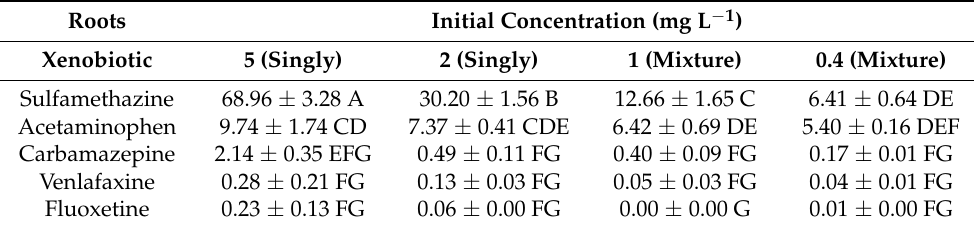
Table 4. Xenobiotic concentration in roots in Tripolium pannonicum. The values 5 and 2 in the table header represent the singly xenobiotic concentration and the values 1 and 0.4 represent each xenobiotic concentration in a mixture of the five xenobiotics in milligram per litre. Values show the mean (in µ g g − 1 FM) ± standard error of three biological replicates per treatment.